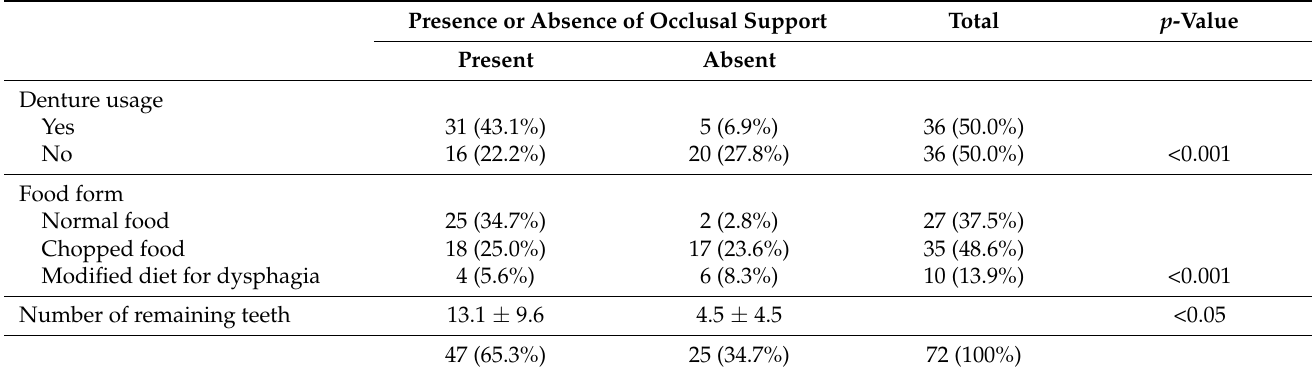
Table 2. Number of denture users, food forms, and remaining teeth according to the presence or absence of occlusal support ( n = 72).